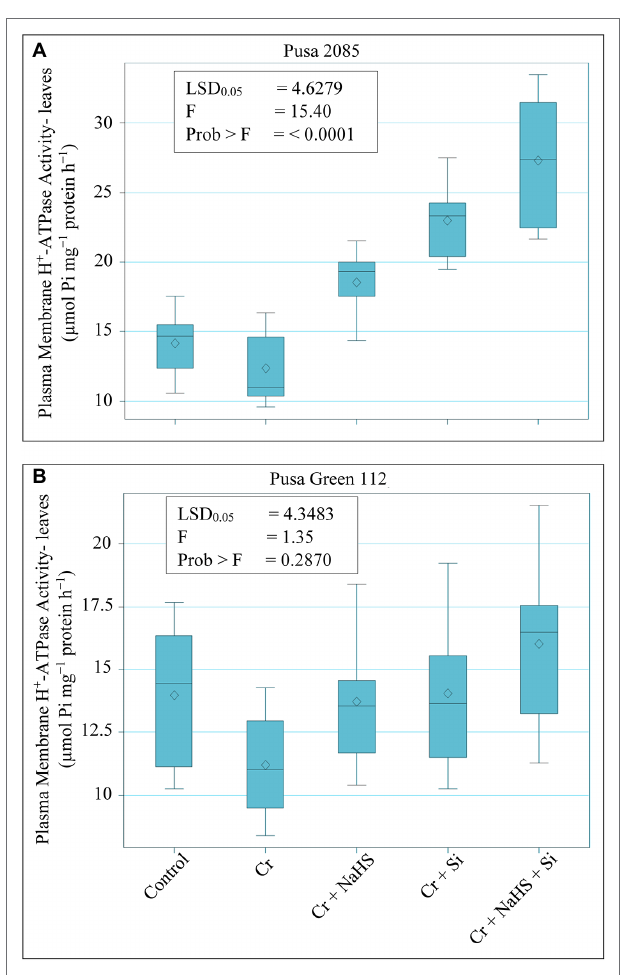
FIGURE 6 | Effect of NaHS, Si, and NaHS + Si treatments on plasma membrane H + -ATPase activity in leaves of both chickpea plants (A) Pusa 2085, and (B) Pusa Green 112 grown during Cr VI stress. Data are presented as mean ± SE ( n = 5) and different bar letters are indicated statistically differences ( p < 0.05) as tested by the least significant difference